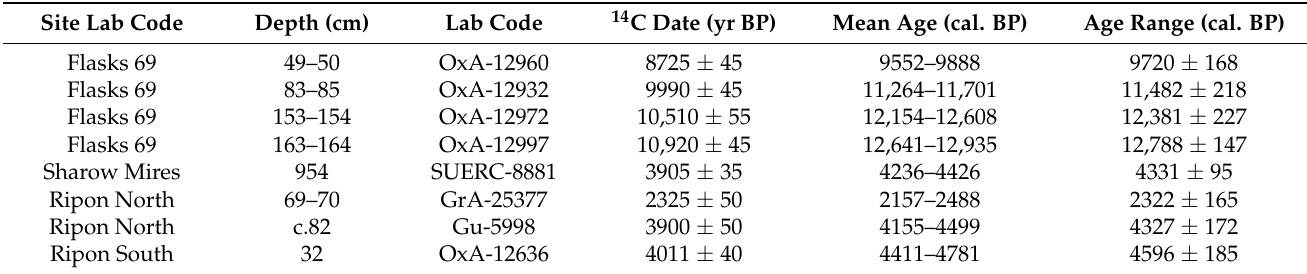
Table 1. Sample details and radiocarbon data from Nosterfield, the Flasks 69 and from other Ure valley fluvial channel sites [18]. Calibrated age ranges (2 δ ) and means are derived using Oxcal 4.2 and IntCal13 [56].